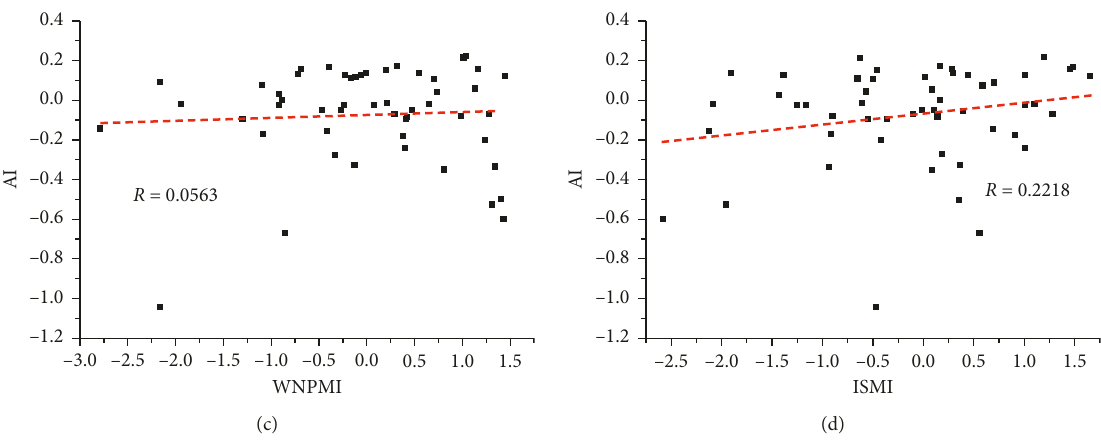
Figure 9: Correlation between AI and MEI, PDO, WNPMI, and ISMI from 1965 to 2017 period,